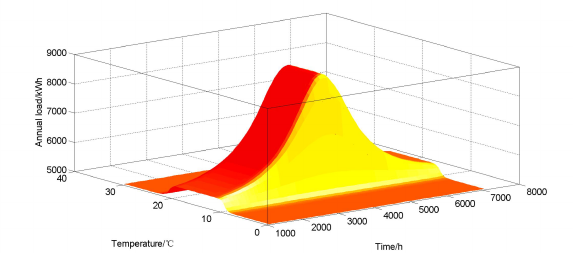
Fig. 1. Annual load changes with temperature and